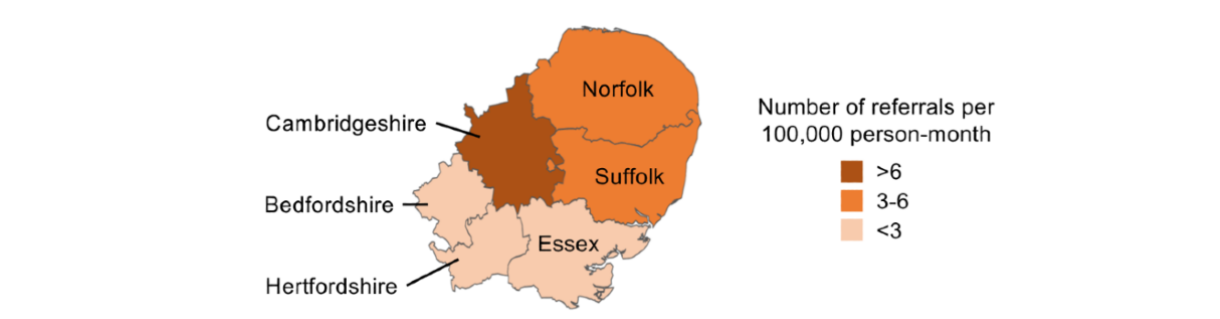
Figure 2. Average incidence of monthly referrals (number of referrals per 100,000 person-month) by subregion in April and September of 2016 and